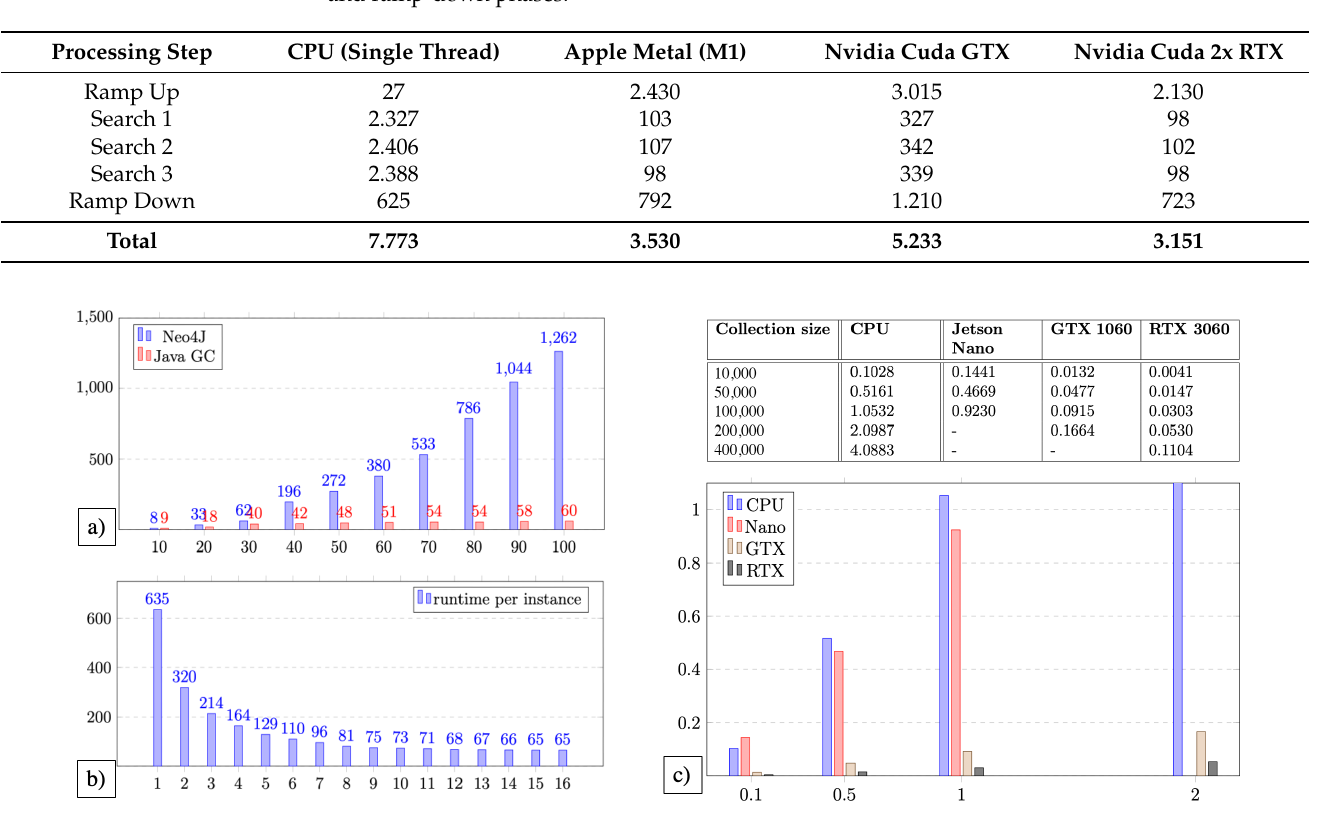
Figure 16. Results in the area of